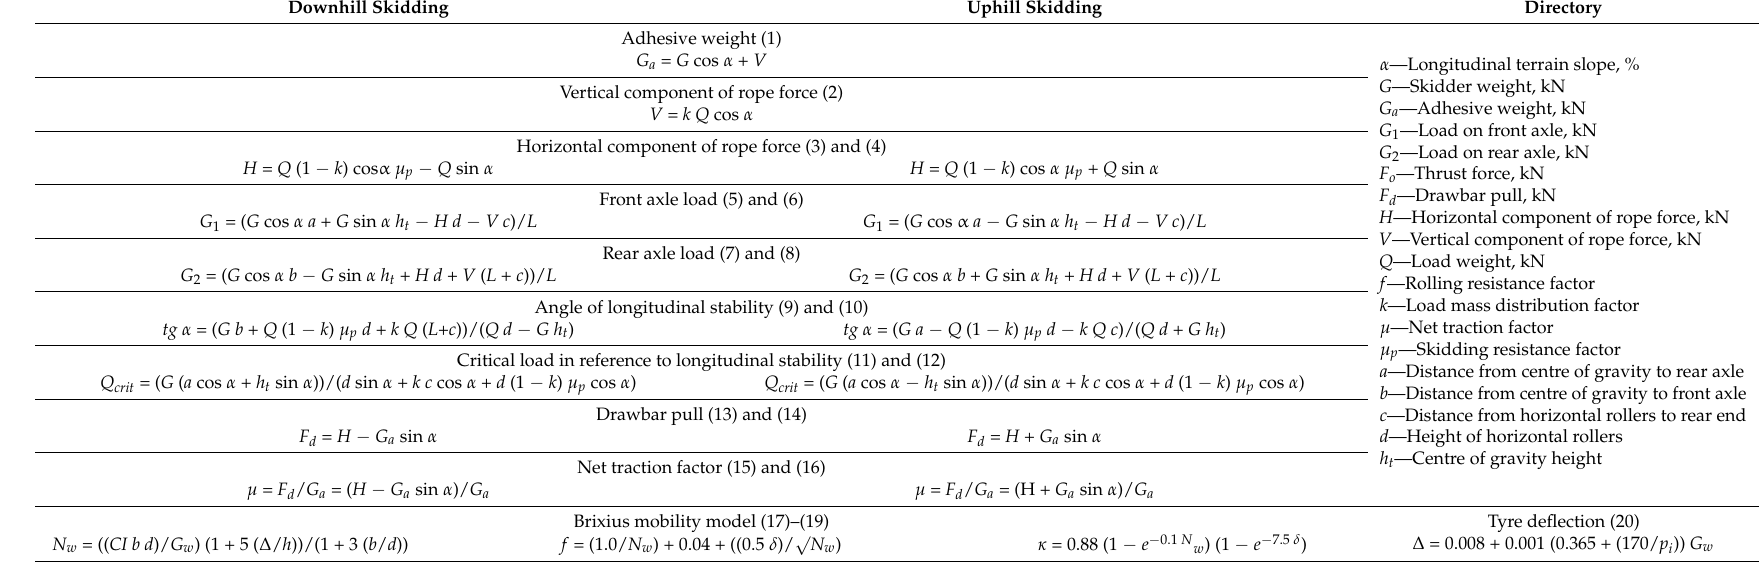
Table 1. Equations used in defining parameters during timber extraction by a cable